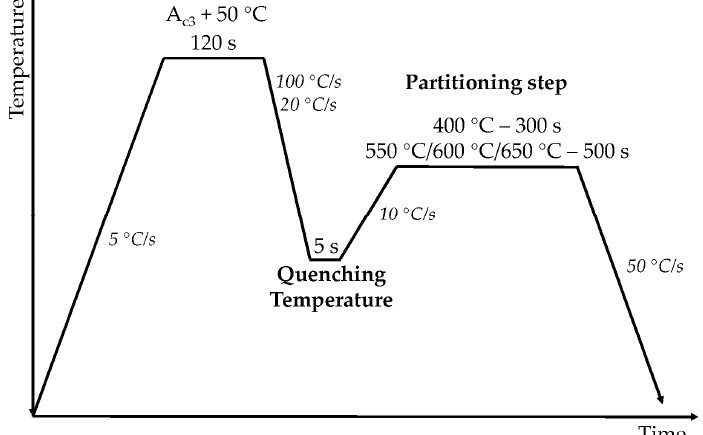
Figure 1. Scheme of the quenching and partitioning (Q&P) processing cycle applied in both the Gleeble system and dilatometer. system and